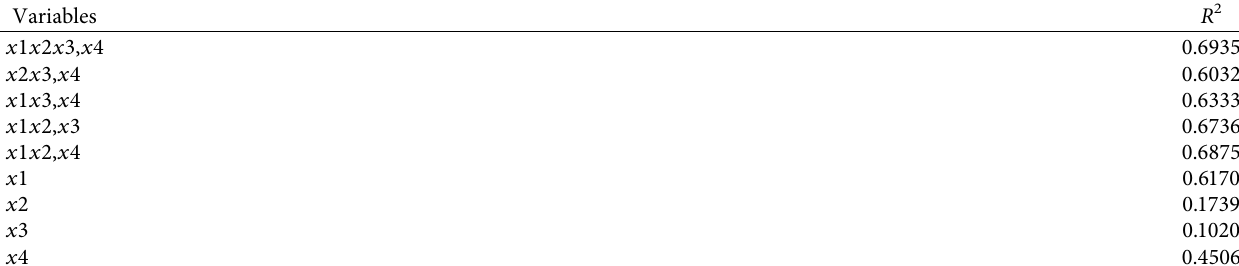
Table 4: The accuracy of the model with the different variable